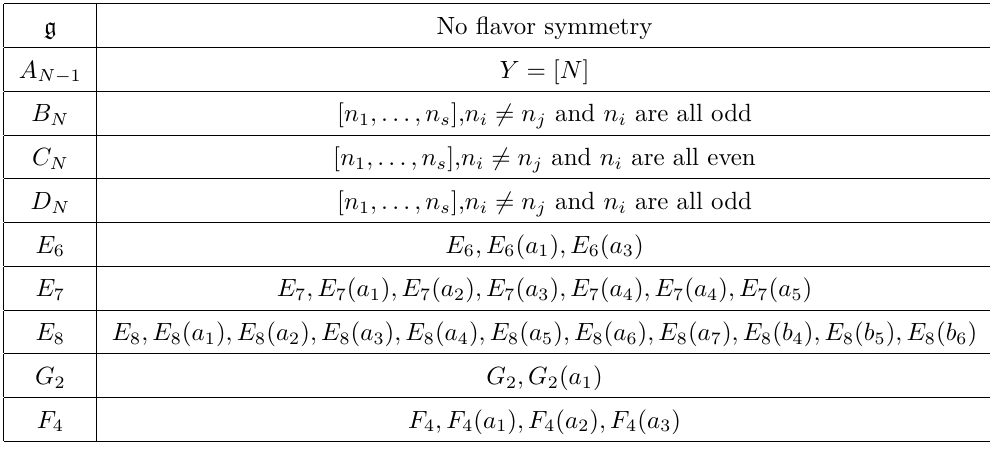
Table 7 . Nilpotent orbits which do not have flavor symmetry. A nilpotent orbit is labeled by a partition for classical groups, and by a Bala-Carter label for exceptional